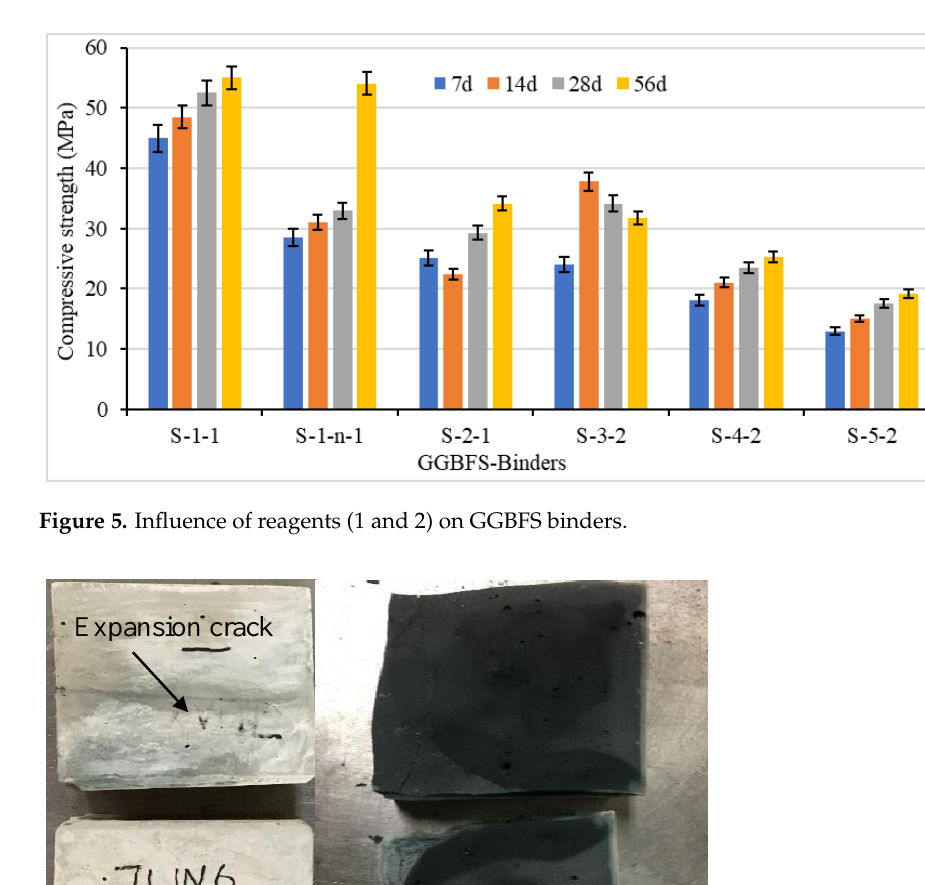
The composition of Ca(OH) 2 : Na 2 SiO 3 ·5H 2 O = 2.5:1 performed the best among the other component ratios for reagent-1, obtaining a compressive strength of 29.5 MPa at 56 days for the binder FS-2-1. This composition had the highest calcium content and the re- quired alkalinity for the dissolution of the Si and Al, which resulted in 6 to 25% higher strengths than the reagent-1/1a-based mix compositions, as evident from Figure 8. The binary binder (FS-4-2) incorporating reagent-2 had setting times greater than 24 h and this correspondingly resulted in a low compressive strength of 4.3 MPa at 28 days. This could be due to the incompatibility between the reagent composition and the source material.